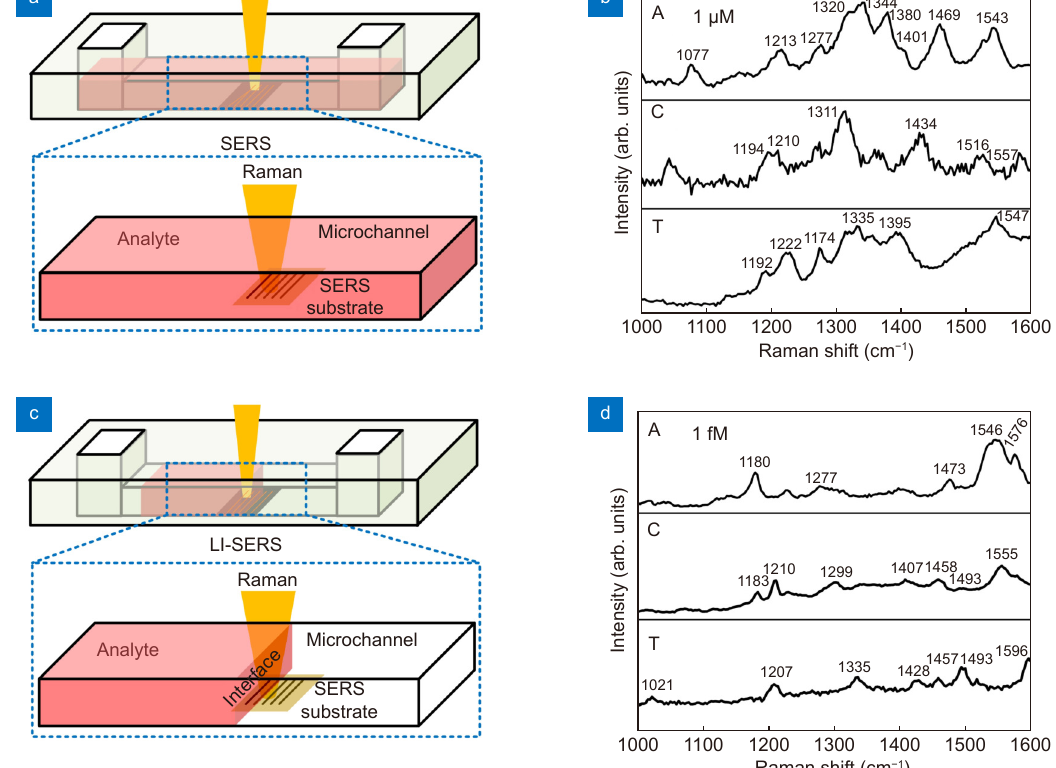
Fig. 3 | ( a , c ) Schematics for regular SERS and LI-SERS measurements of analyte solutions in the microchannel, respectively. ( b , d ) Raman spectra of DNA bases, adenine (A) and cytosine, (C) and thymine (T), measured using microfluidic SERS chips with 2-D nanostructured SERS substrates by regular SERS for 1 μM concentration and LI-SERS for 1 fM concentration,